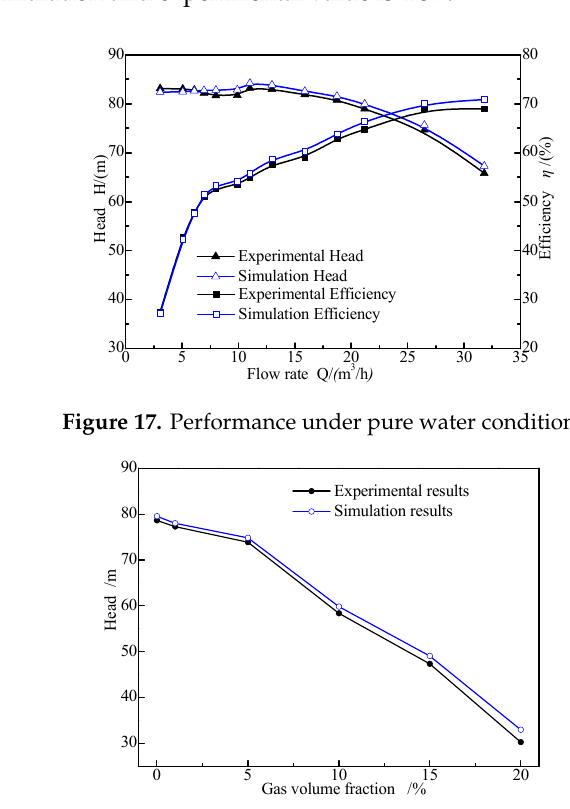
Figure 18. Comparison of simulation with experimental results under different GVFs.